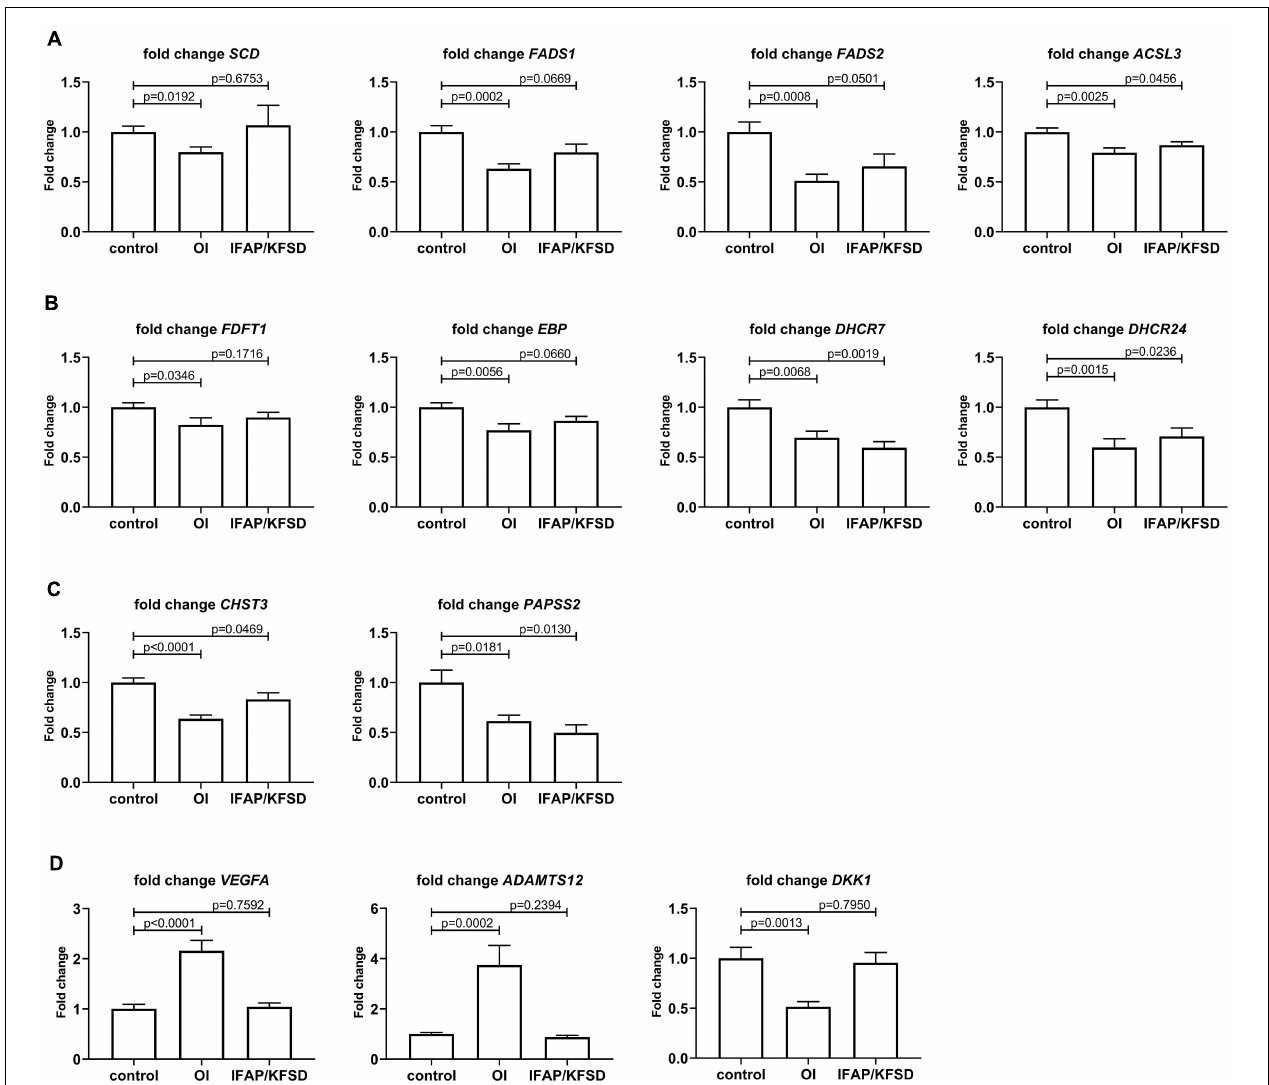
FIGURE 9 | qRT-PCR was performed to validate the RNA-sequencing results for (A) SREBP-dependent genes involved in fatty acid metabolism, (B) SREBP-dependent genes involved in sterol metabolism, (C) OASIS-dependent genes involved in skeletal development, and (D) genes involved in bone or cartilage homeostasis that are differentially expressed in MBTPS2 -OI compared to control. Gene expression was measured in four independent replicates per subject, and t-tests were performed for statistical analysis. Data are expressed as mean ±